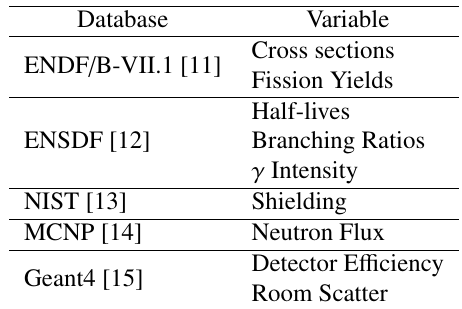
Figure 1: Measured spectra using PUNITA [3] (left) and a 252 Cf source in PERLA [4] (right).